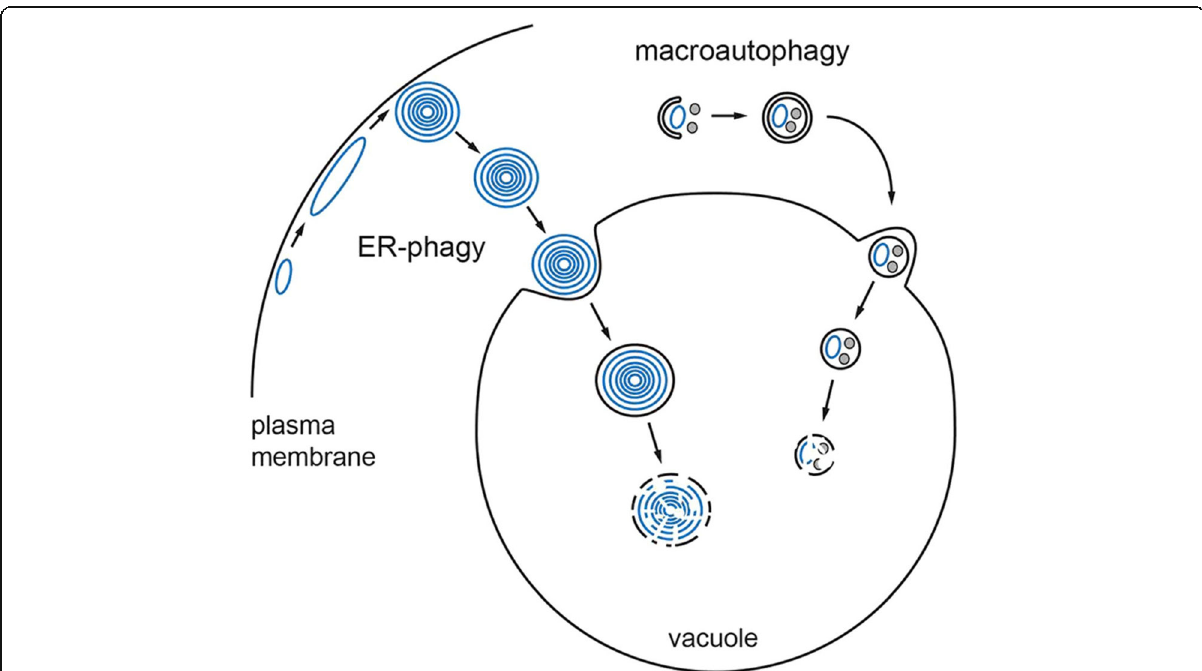
Fig. 3 Pro-survival ER-phagy and macroautophagy degradation of cellular components in a vacuole to maintain cellular homeostasis. ER-phagy packages excessive ER abundance in ER-whorls (concentric blue circles) and degrades them within an intracellular membranous vacuole, the lysosome. Macroautophagy engulfs cytoplasmic, misfolded proteins (small, grey circles), and non-functioning, aged intracellular membranes (blue ovals) and degrades them within the lysosome. To maintain cellular homeostasis, the degraded products are recycled (not shown). ER , Endoplasmic reticulum. Reprinted with permission from Schuck et al.